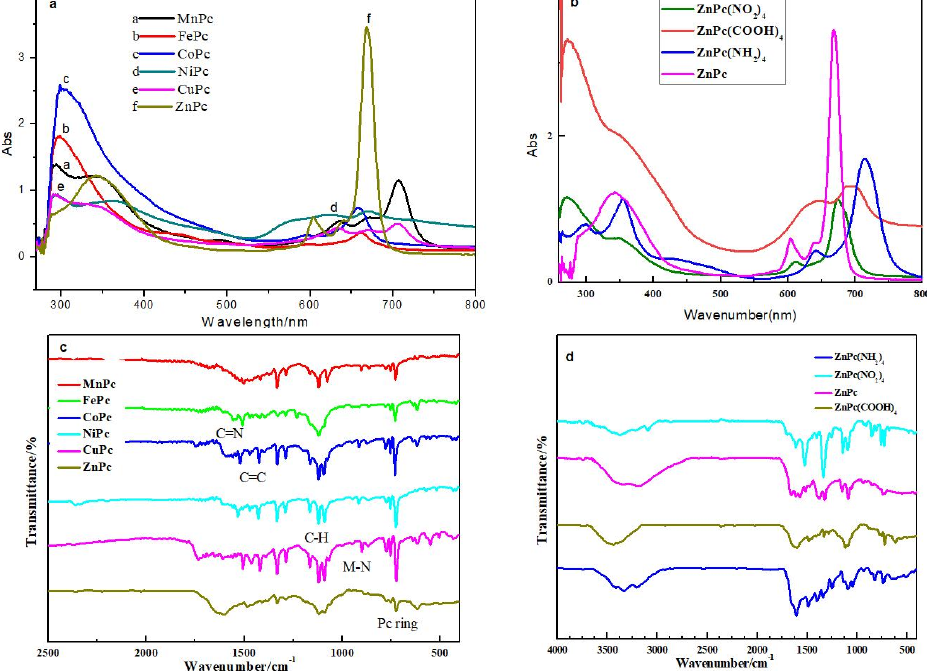
Figure 4. UV-Vis and FTIR spectra of MPcR 4 compounds. ( a , b ): UV-Vis spectra of MPcR 4 ; ( c , d ): FTIR spectra of MPcR 4 .